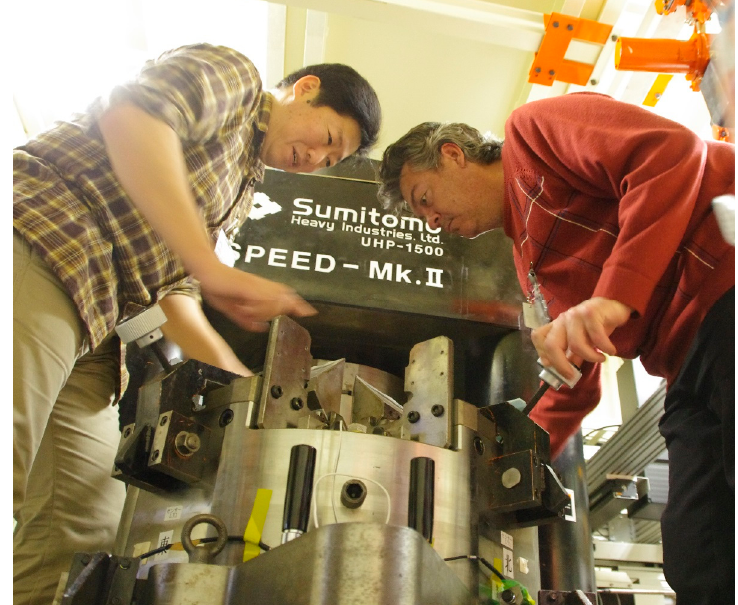
Figure 4. Design of pressure cell 14 M TEL5 ( b ) and photograph of the individual parts ( a , left dish) and specimens ( a , right dish).